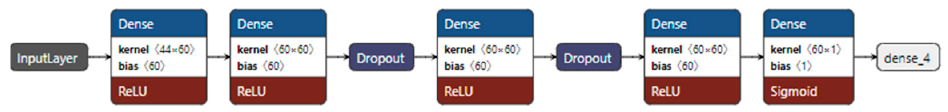
Figure 18. Neural network optimized layers used in the research.